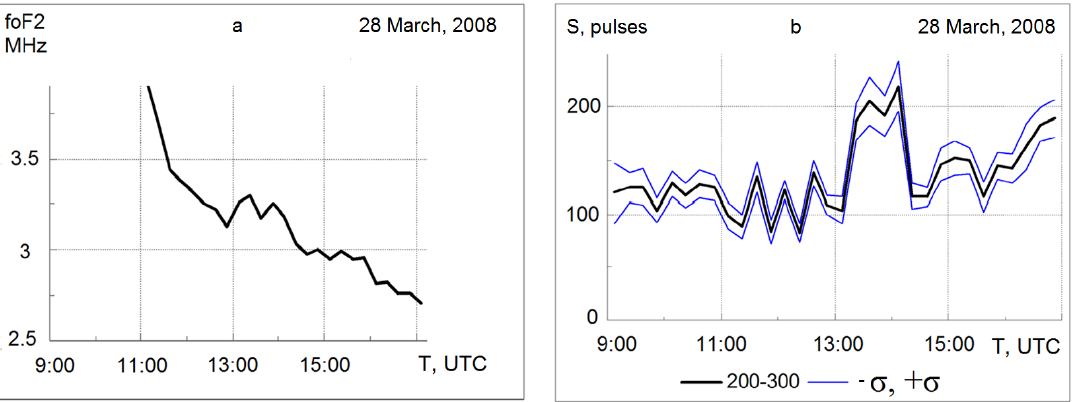
Figure 1. Temporal variations ( a ) of the critical frequency foF2 of the ionospheric F2 layer and ( b ) of the backscattered lidar signal observed at altitudes from 200 to 300 km [10].